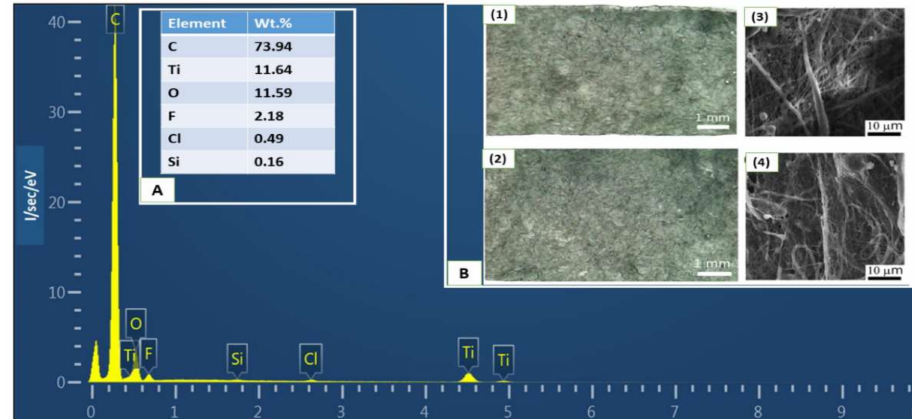
Figure 6. EDS spectrum of the MXene-PCL nanocomposite with element Wt.% distribution (insertion ( A )). Insertion ( B )—optical (1) and (2) and SEM images (3) and (4) of PCL-MXene composite scaffolds after first and second coating iteration, respectively.